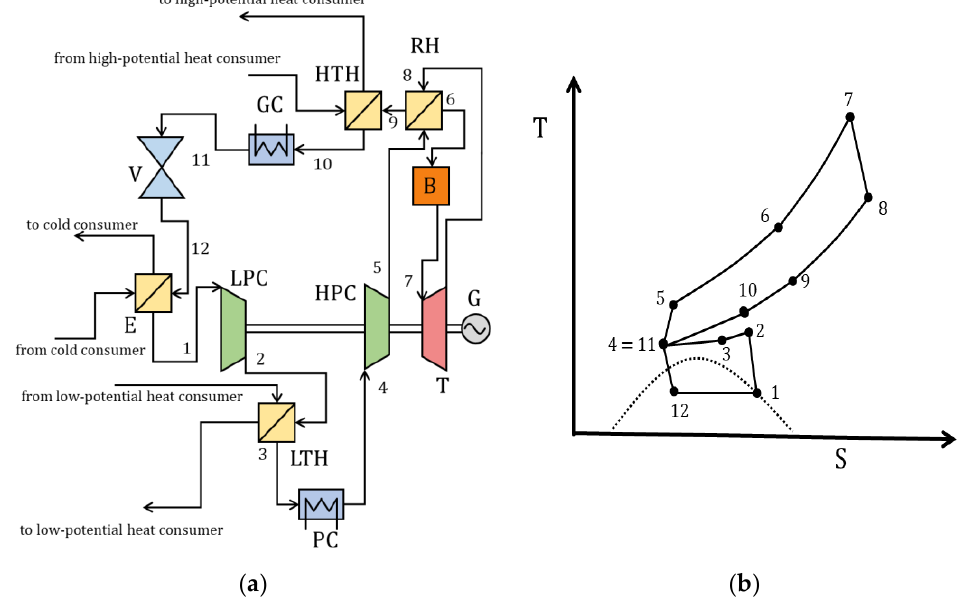
Figure 13. Supercritical CO 2 Brayton cycle with trigeneration based on supercritical carbon dioxide: ( a ) schematic diagram; ( b ) T – S diagram [22]. B — boiler; T — turbine; G — generator; HTR — high-temperature regenerative heat exchanger; LTR — low-temperature regenerative heat exchanger; LTH — low-temperature heater; HTH — high-temperature heater; V — valve; LPC — low-pressure compressor; HPC — high-pressure compressor; E — evaporator; GC — gas cooler; PC — precooler.